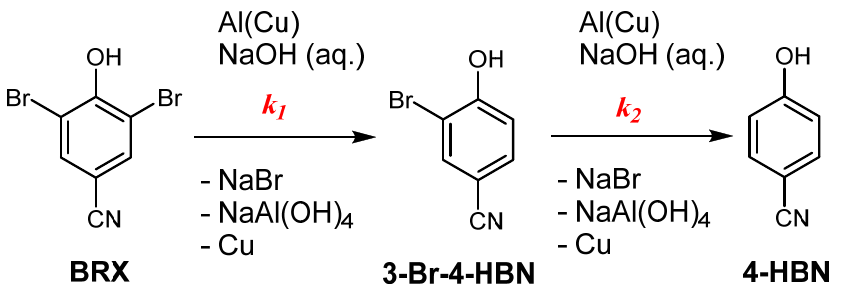
(Table S2, Entry 5). These findings are in the agreement with our previous results regarding the HDB of 2,4,6-tribromophenol [26].